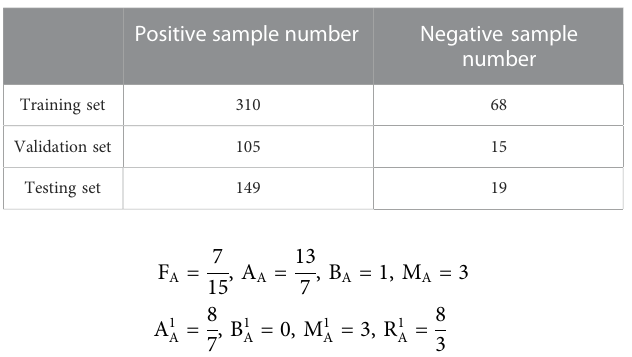
TABLE 1 Information of positive and negative samples in each data set.